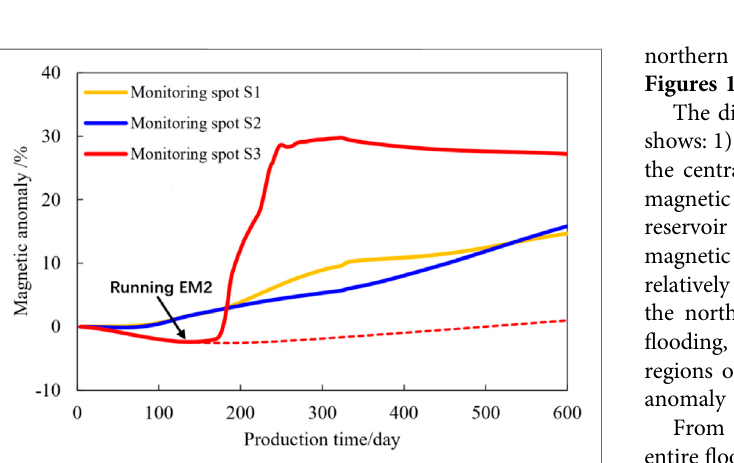
Frontiers in Earth Science |